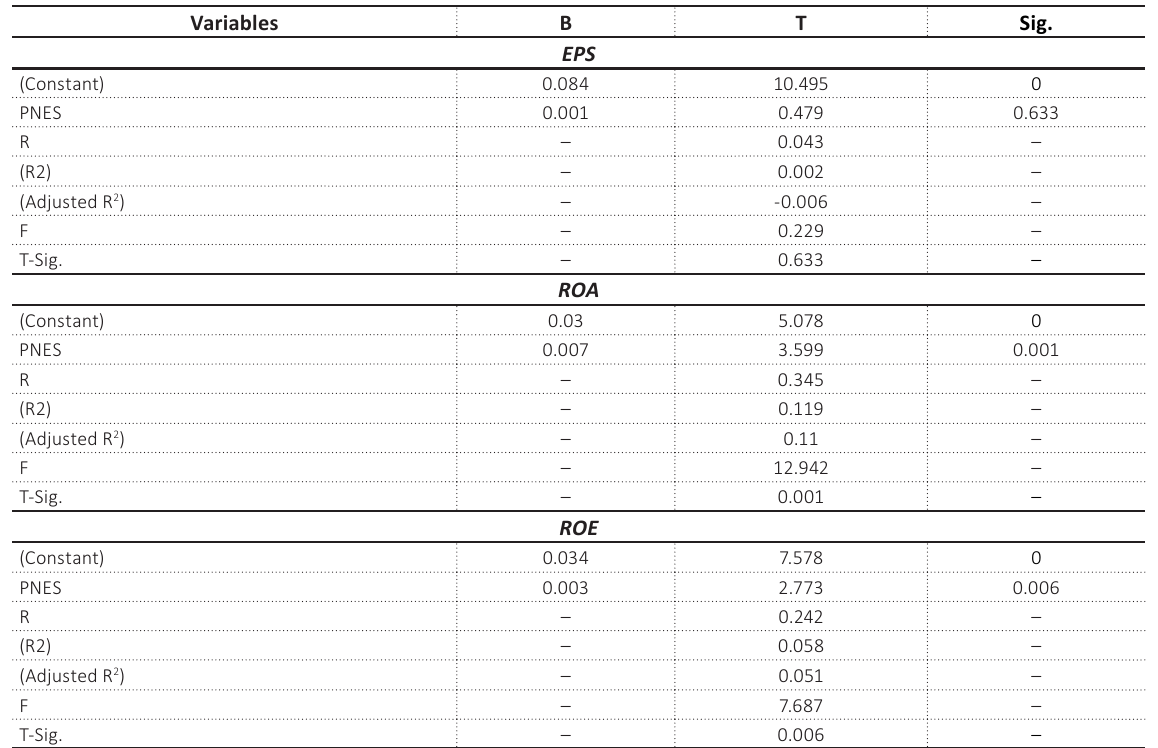
Table 3. Results of simple linear regression analysis of